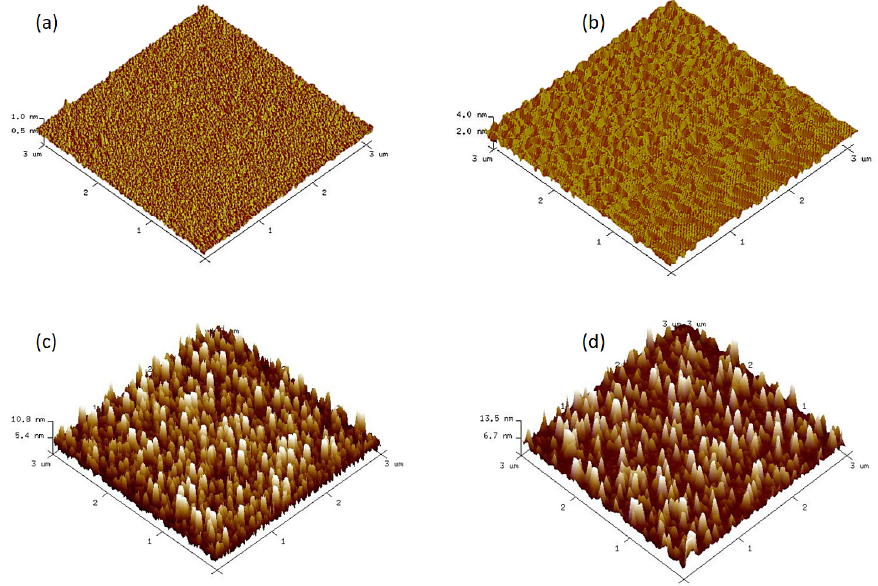
Figure 8. Surface roughness of the pristine ( a ) PMMA and ( b ) silicon. ( c ) 3D AFM images of the PMMA sample after a 90 s plasma treatment time and ( d ) of the silicon sample after a 90 s H 2 O plasma treatment time.